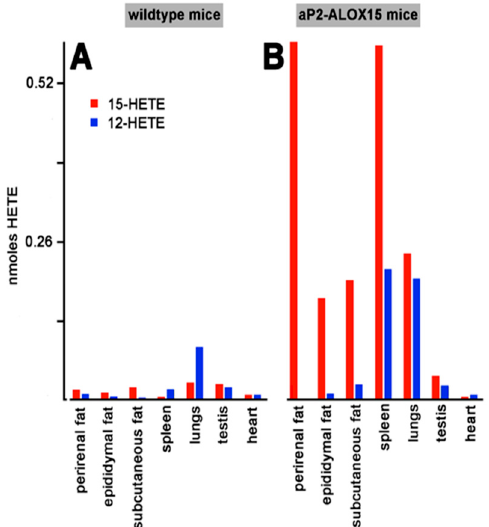
Figure 5. Ex vivo activity assays of solid tissues prepared from aP2-ALOX15 mice and corresponding wildtype controls. Homogenate supernatants were prepared from solid tissues of aP2-ALOX15 mice and corresponding wildtype controls. Aliquots of these supernatants (normalized to the protein content of the homogenate supernatants) were incubated in PBS with arachidonic acid as described in Section 4, and the oxygenation products were analyzed by RP-HPLC. 12-HETE and 15-HETE were separately quantified, and the area units of the two peaks were converted to nmoles HETE